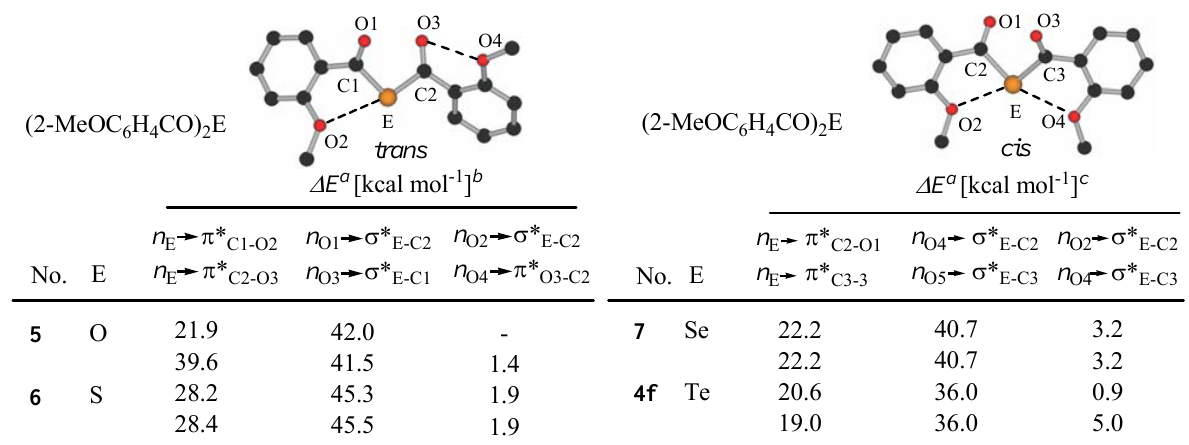
H CO) E [E = O ( 5 ), S ( 6 ), Se ( 7 ), Te ( 4f 6 4 2